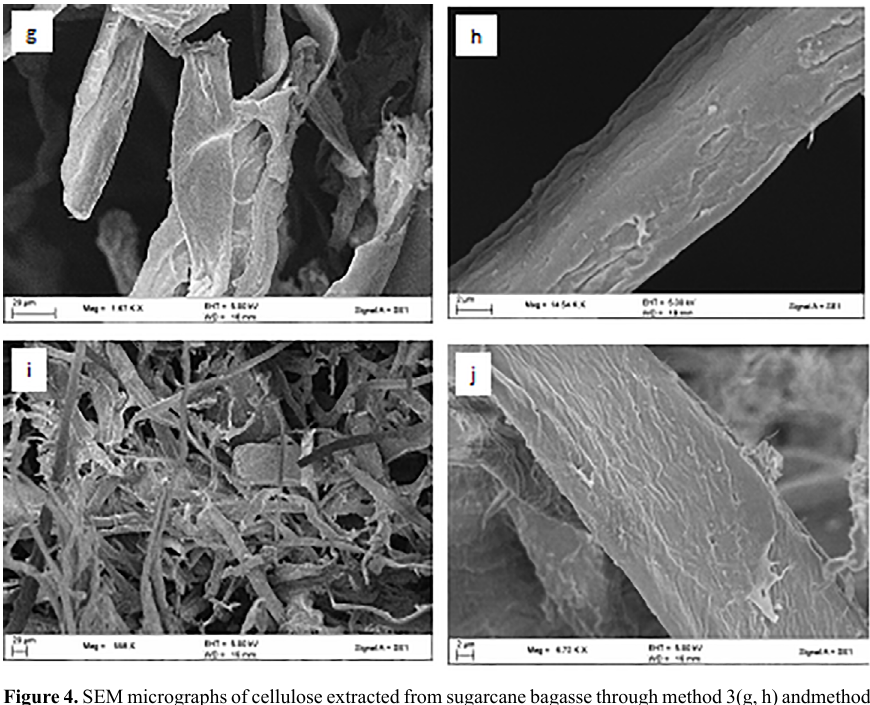
Figure 4. SEM micrographs of cellulose extracted from sugarcane bagasse through method 3(g, h) andmethod 4 (i, j)